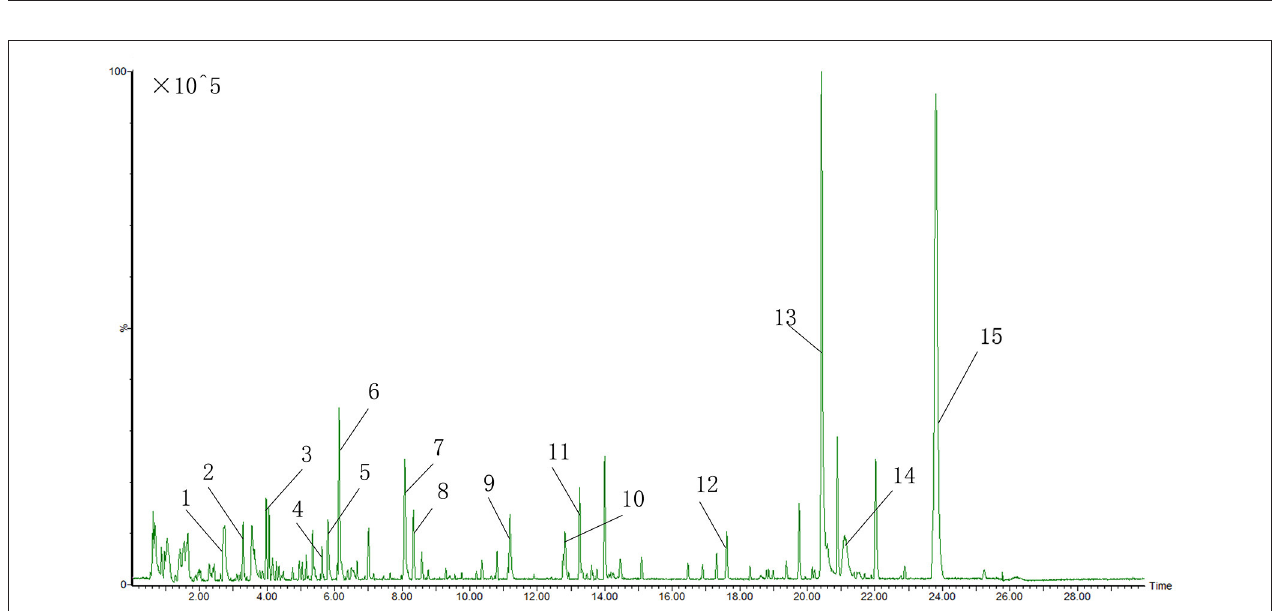
FIGURE 4 | Result of 6MWT and ejection fraction results. (A) 6MWT result between Prior-CHM group and Prior-Placebo group & Post-CHM group and Post-Placebo group, # P < 0.05 for Post-CHM group and Post-Placebo group. (B) Ejection fraction result between Prior-CHM group and Prior-Placebo group & Post-CHM group and Post-Placebo group, * P < 0.05 for Post-CHM group and Post-Placebo group. 6MWT, 6Min Walking Test; CHM, Chinese herbal medicine; LVEF, Left Ventricular Ejection Fraction.